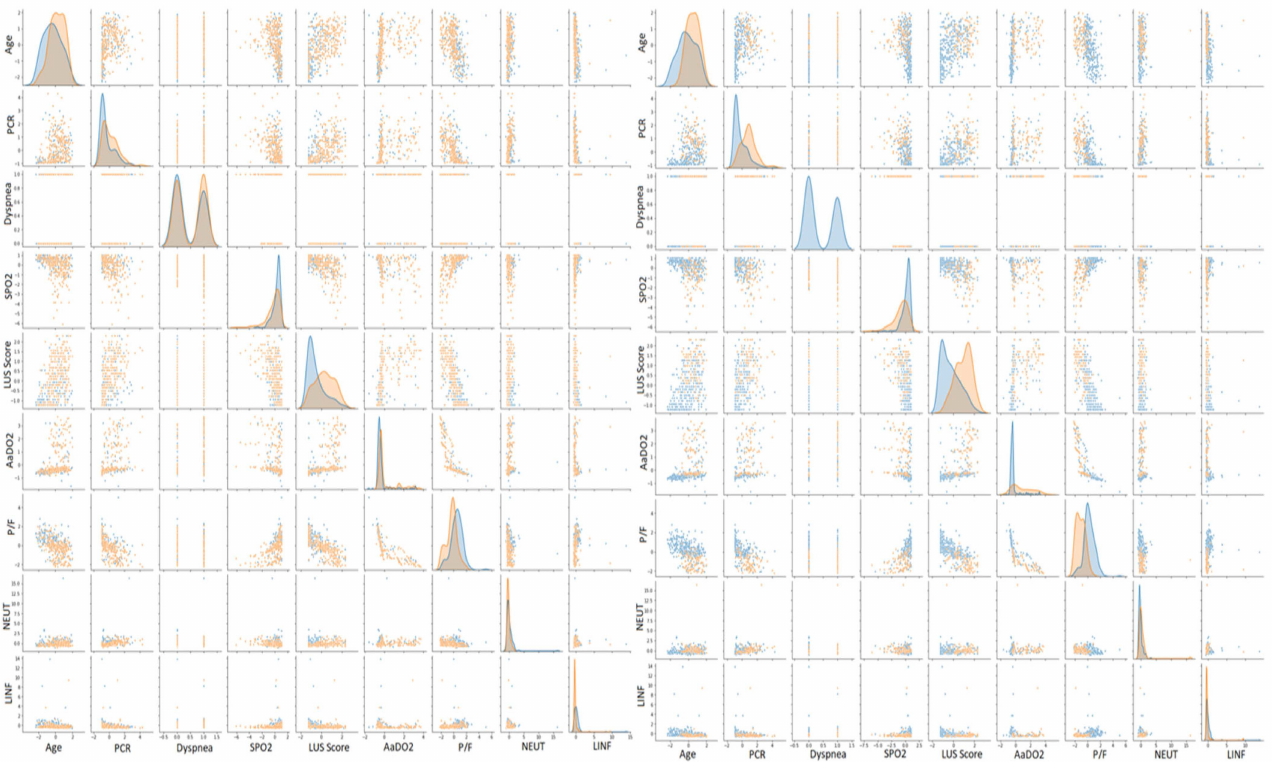
Figure 3. Scatter plot matrices for COVID-19 and oxygen therapy prediction. On the left, orange points indicate positive patients, whereas blue points indicate negative ones. On the right, orange points indicate patients who needed CPAP or invasive ventilation, whereas blue points indicate patients who needed either an oxygen mask, nasal cannula, or no oxygen therapy.